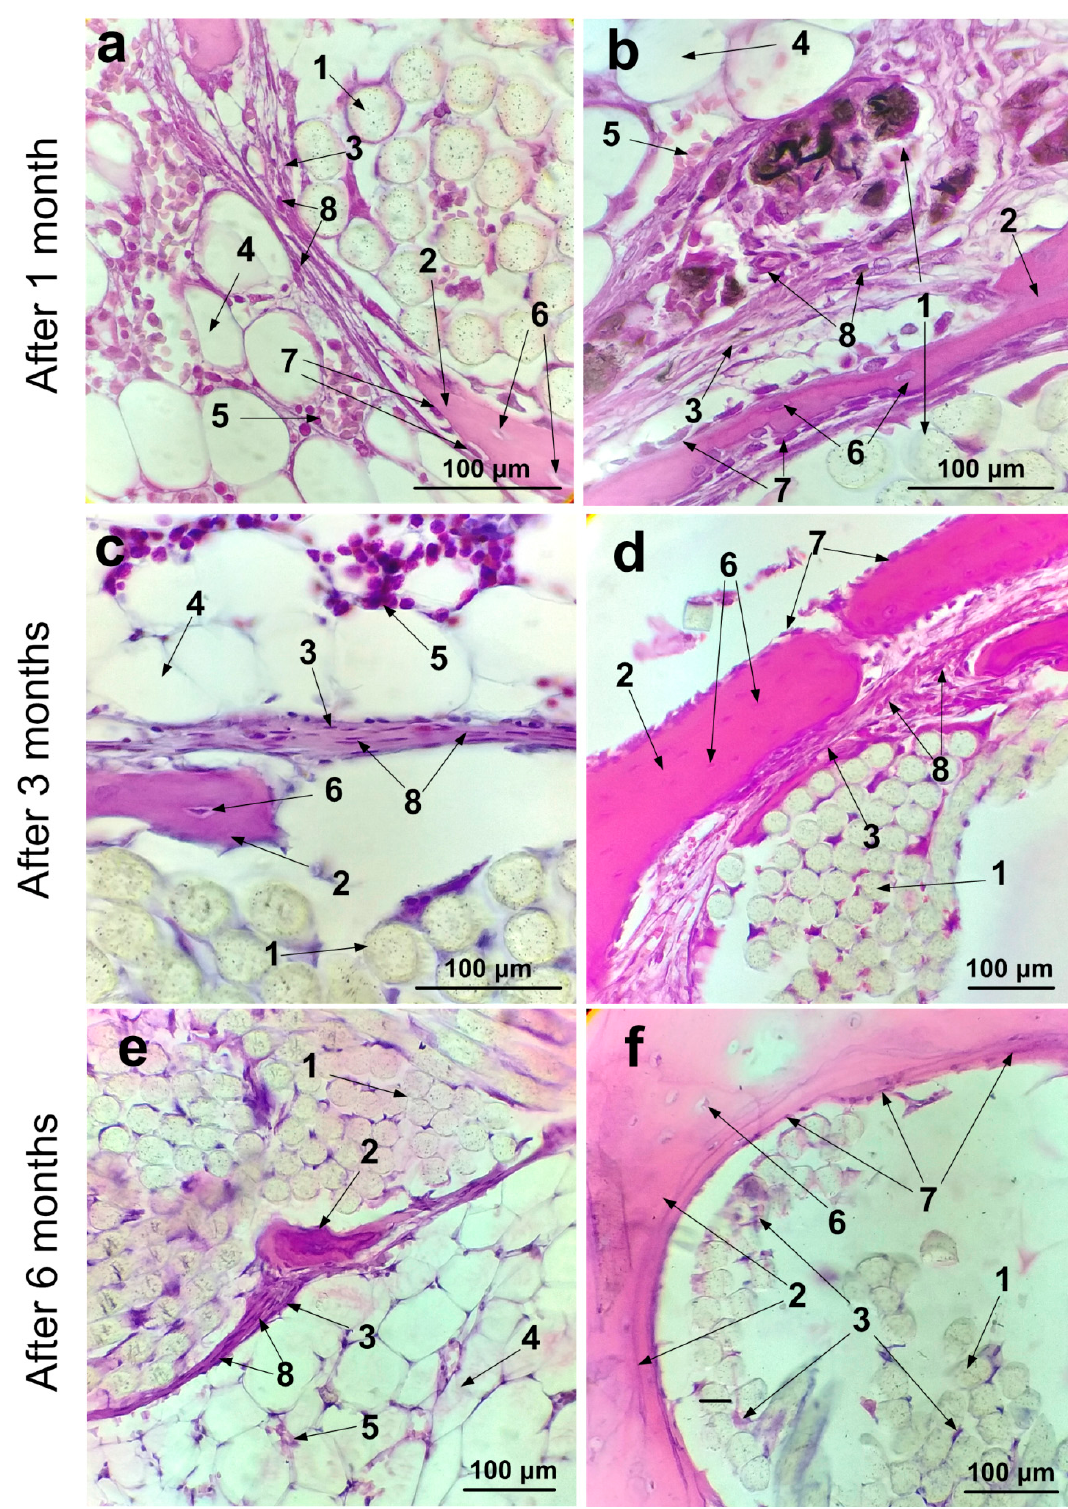
Figure 9. Enlarged images of histological sections with visualization of cells in the implantation area in 1 ( a , b ), 3 ( c , d ), and 6 ( e , f ) months of control ( a , c , e ) and a PET tape coated with SWCNT collagen ( b , d , f ), where 1 —a PET tape fiber; 2 —bone trabeculae; 3 —connective tissue; 4 —reticular tissue; 5 —blood cells at different stages of hematopoiesis; 6 —osteocytes; 7 —osteoblasts, 8—fibroblasts.